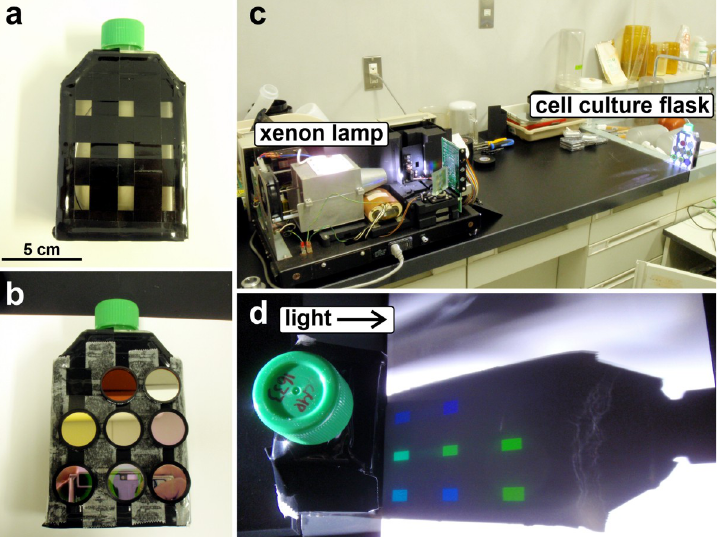
Fig 1. A cell culture flask and xenon lamp were used to assess the phototaxis of Symbiodiniaceae cultured strains. a) 250-mL cell culture flask with black PVC tape attached in a grid shape. b) Eight types of band-pass optical filters ( ø 25 mm) were attached with double-sided tape. c) The cell culture flask with band-pass filters was placed in front of the xenon lamp source. d) A specific wavelength of light passed through each band-pass filter into the cell culture flask. To count the symbiodiniacean cells, 1 mL of medium was collected from each grid using a Pasteur pipette inserted from the mouth of cell culture flask.